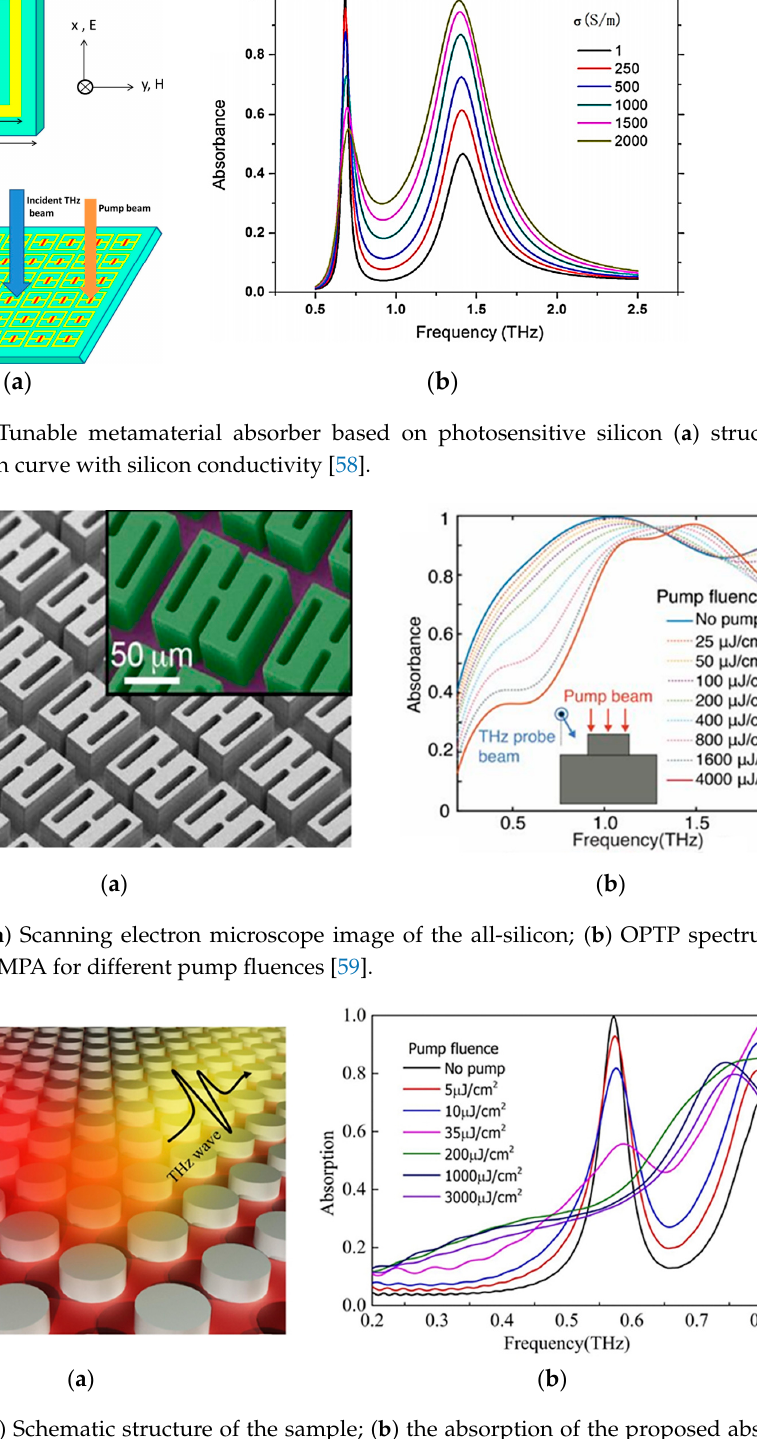
Figure 23. ( a ) Schematic structure of the sample; ( b ) the absorption of the proposed absorber for different pump fluences [60].